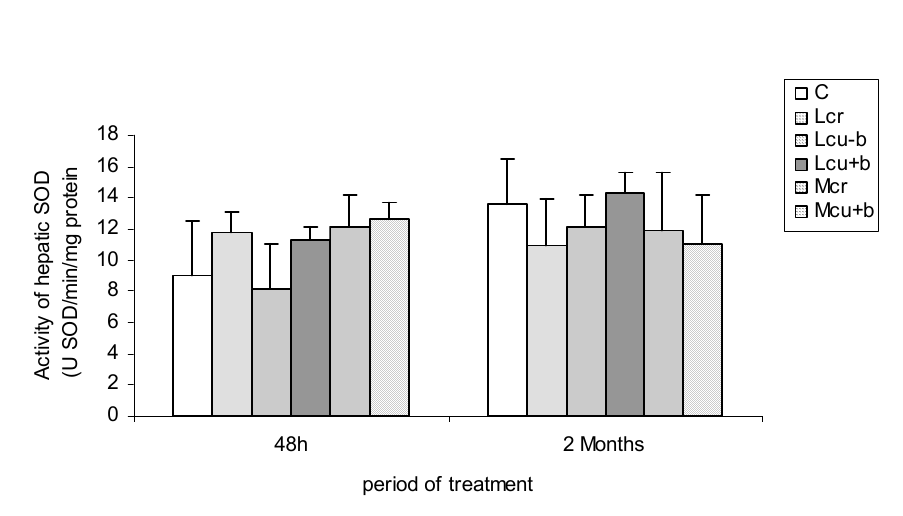
Figure 5. Superoxide dismutase activity in the liver of control and treated rats (Lcr, Lcu-b, Lcu+b, Mcr and Mcu+b). The values are expressed as mean ± SEM (n = 6).